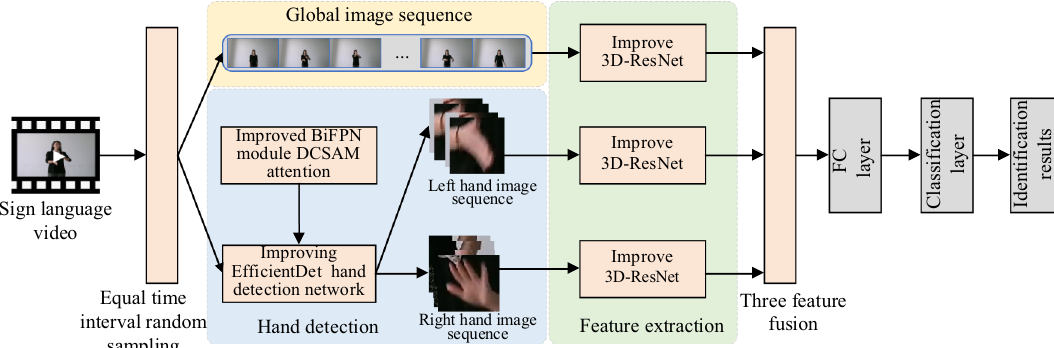
Figure 1. Framework of improved 3D-ResNet sign language recognition algorithm to enhance hand